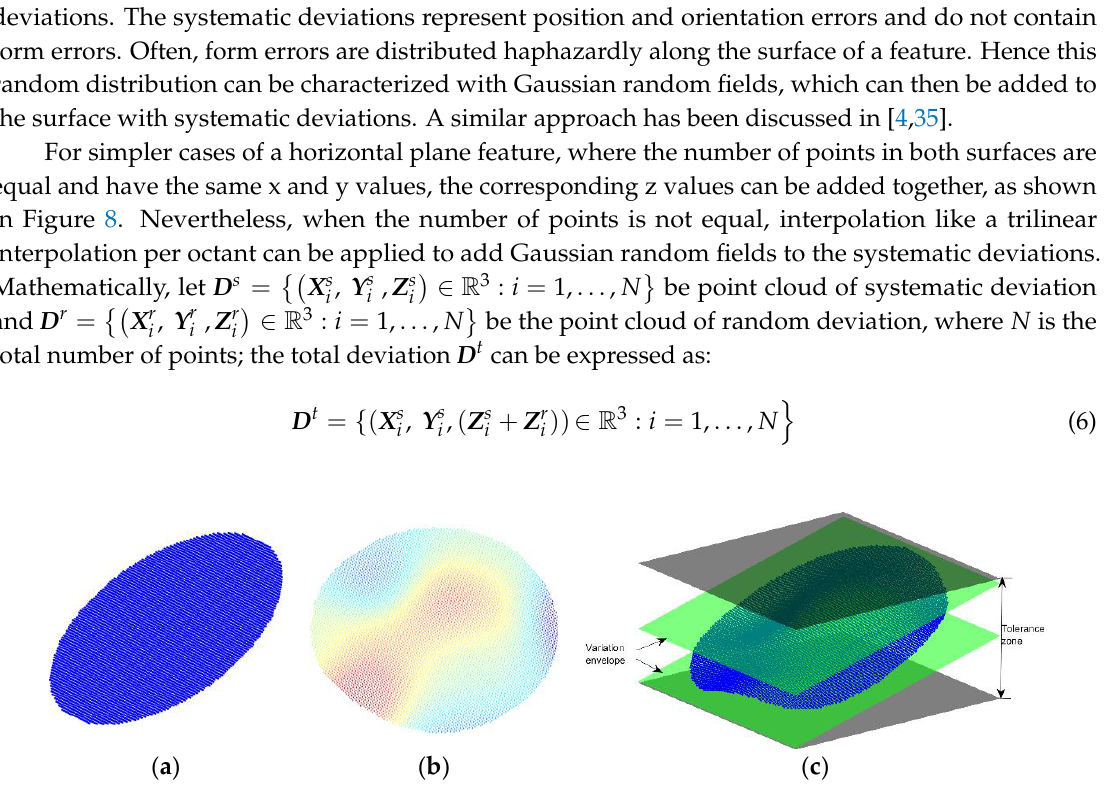
Figure 7. Illustration of locator deviations and possible effects on a model, along with tooltip deviation.